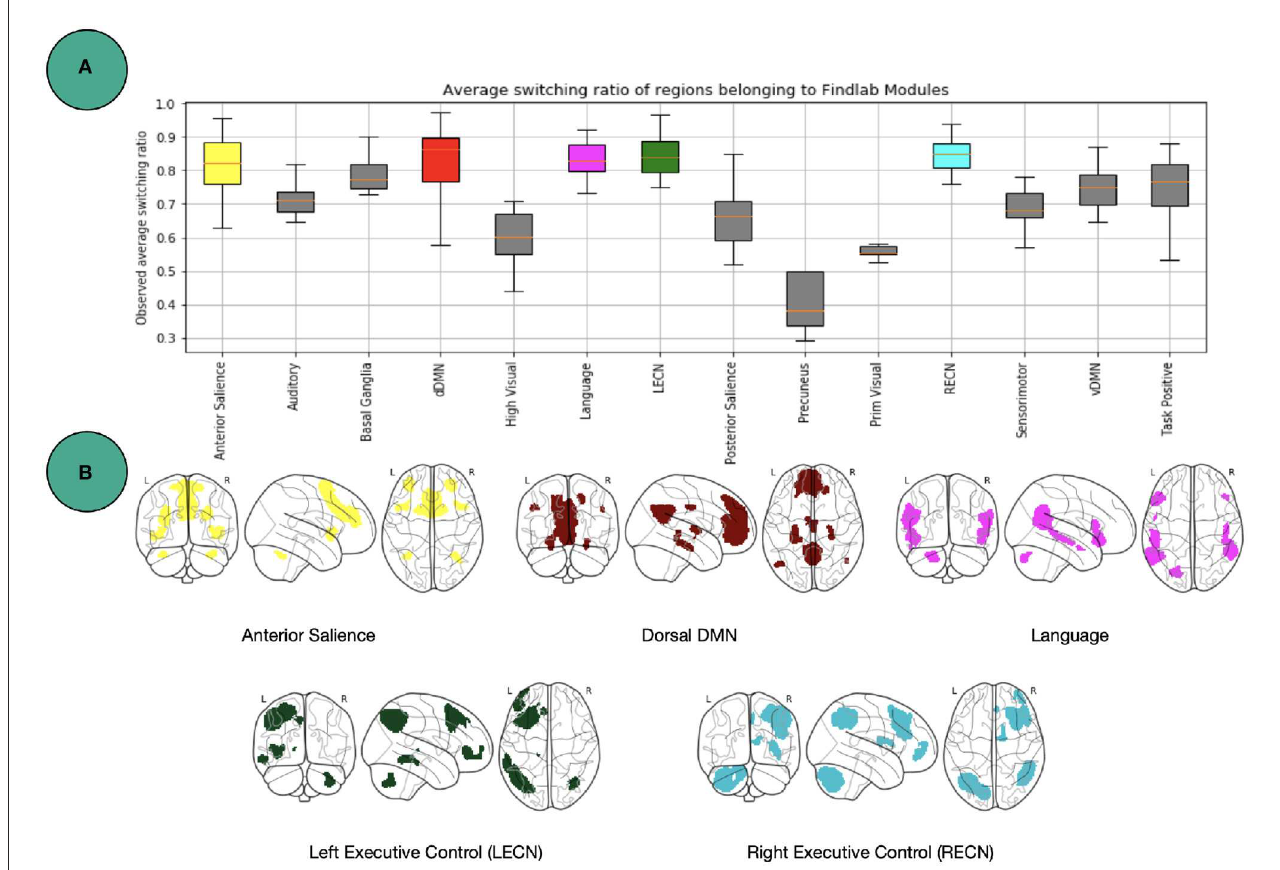
FIGURE5 Findlab brain areas switching. (A) Average number of affiliation switches between consecutive windows for each FIND lab template network, averaged across all subjects. Abbreviations are listed in Table 2. (B) Illustration of the four template networks for which its constituent nodes demonstrated the highest flexibility [http://findlab.stanford.edu/; Shirer et al. (2012)]. See Figure 6 for more